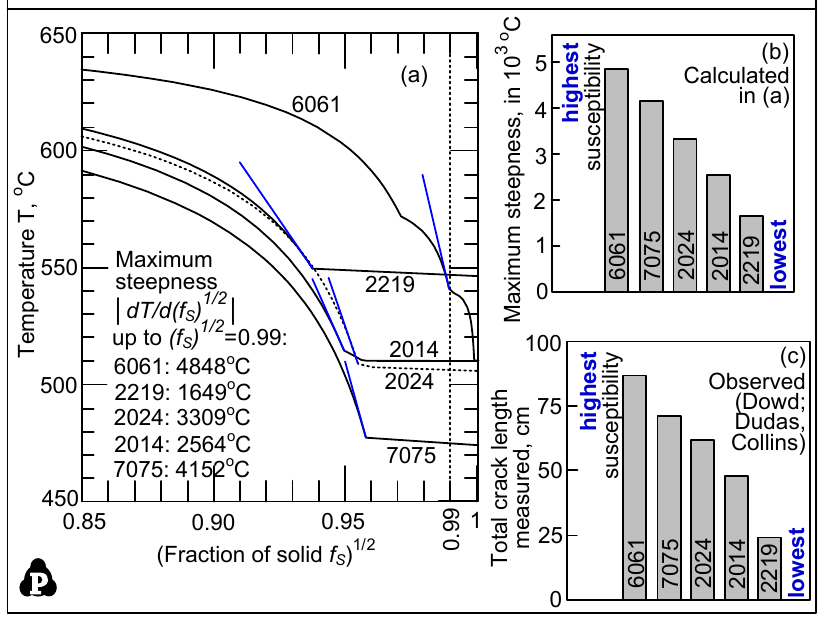
Figure 7 . Susceptibility of wrought Al alloys to solidification cracking: ( a ) curves of T vs. ( f S ) 1/2 ; ( b ) ranking based on Kou’s index data from [17]; ( c ) ranking based on crack susceptibility tests by Dowd [35] and Dudas and Collins data from [36].